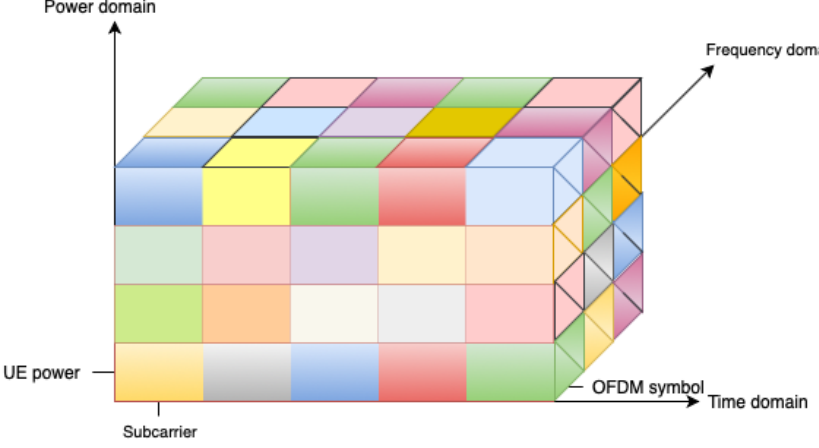
Figure 4. Resource allocation of NOMA